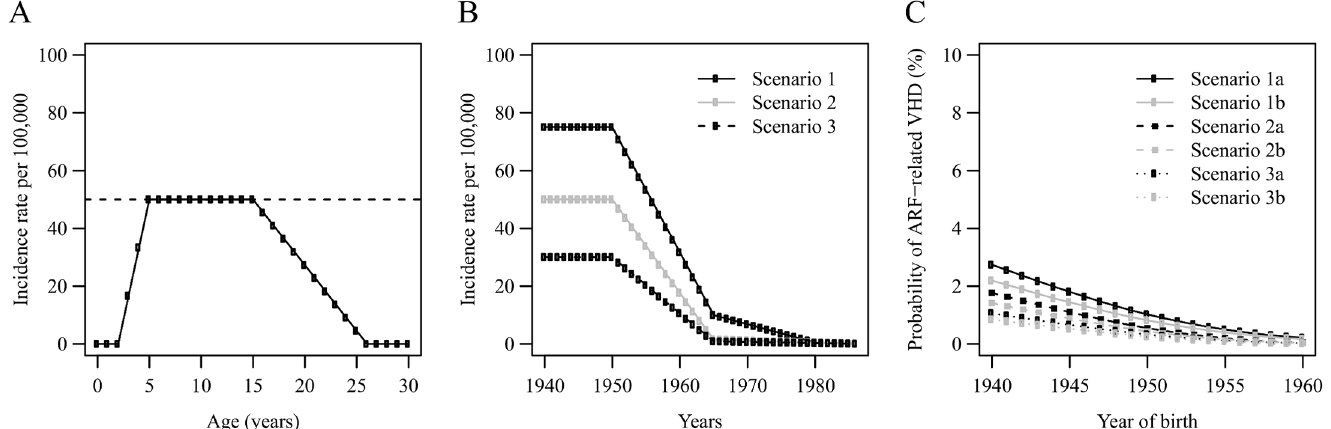
Fig 1. ARF incidence rates and resulting probability of ARF-related VHD. Panel A displays the shape of the incidence rate of ARF according to patient age between 0 and 30 years, for a reference incidence rate of 50 per 100,000. Panel B presents the reference incidence rate for each year between 1940 and 1986 for the three core scenarios. The results on the probability of ARF-related VHD in a patient presenting in 2013 with VHD and a history of benfluorex are given on the panel C , according to the year of birth of the